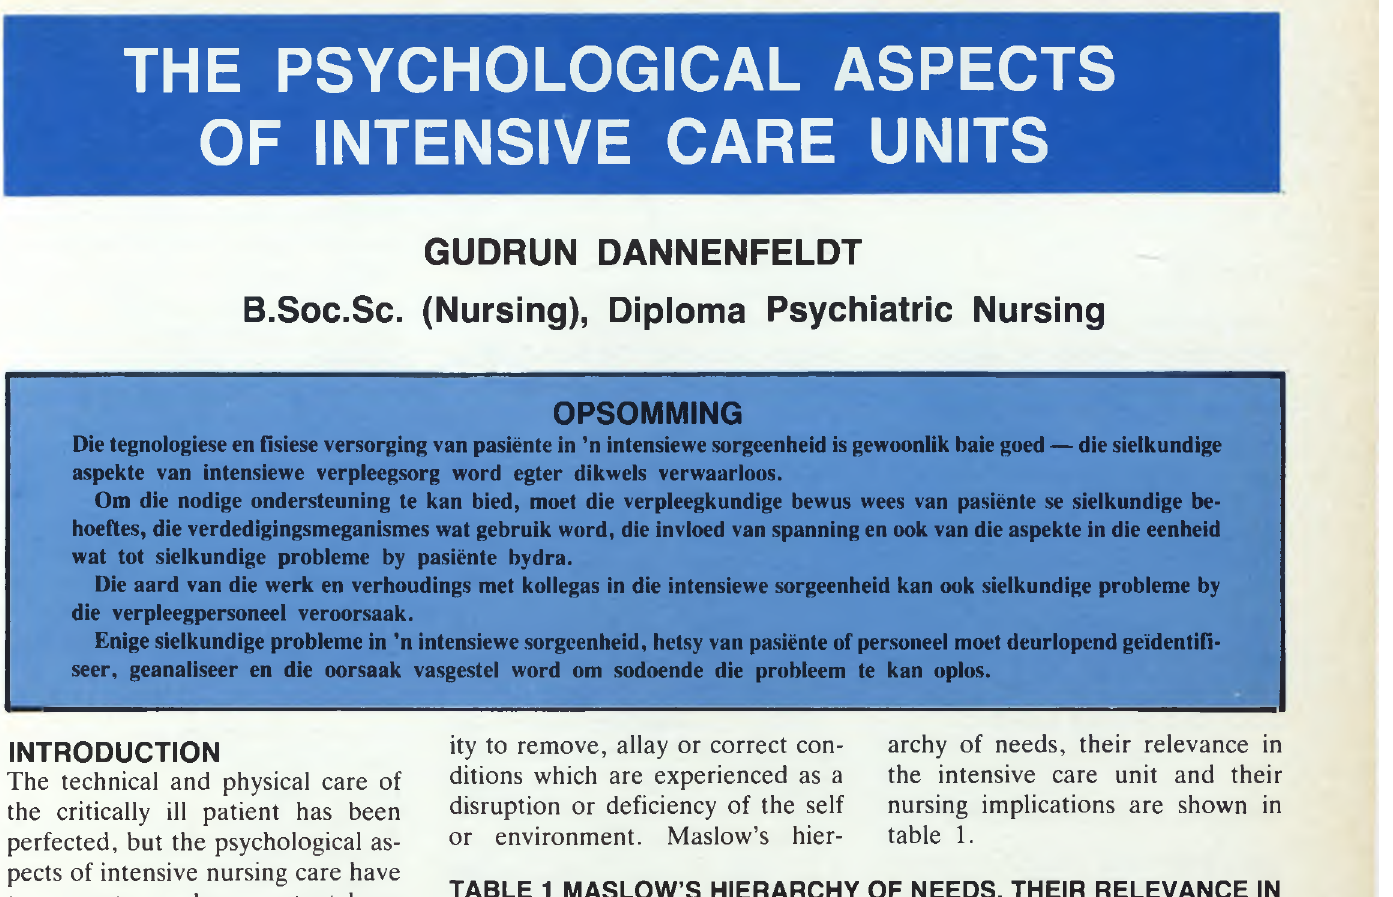
THE INTENSIVE CARE UNIT AND IMPLICATIONS FOR